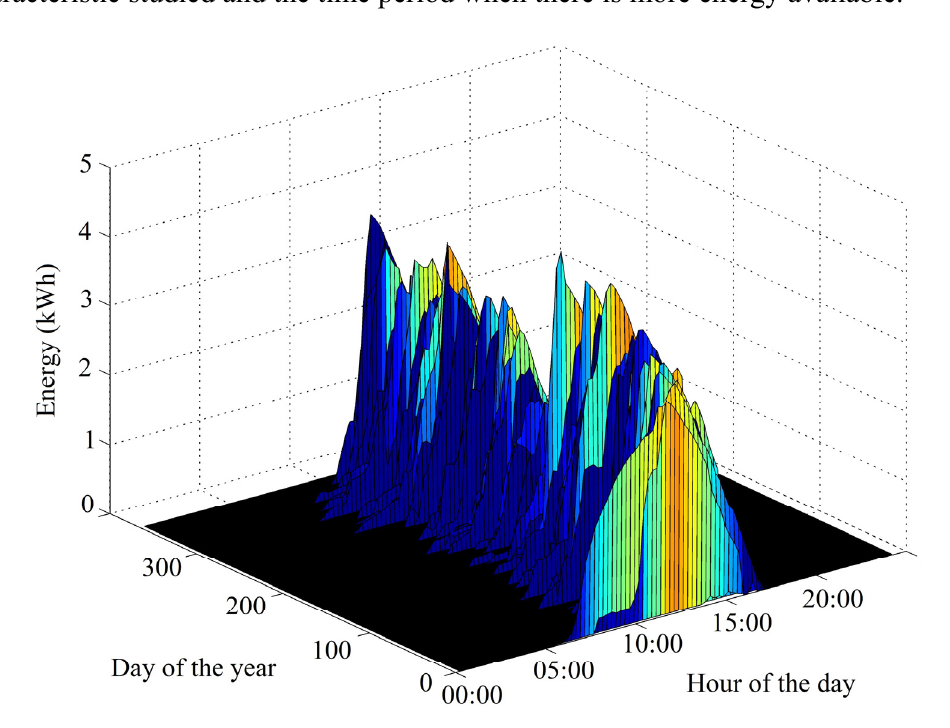
Figure 8. Photovoltaic energy not consumed on the microgrid for topology